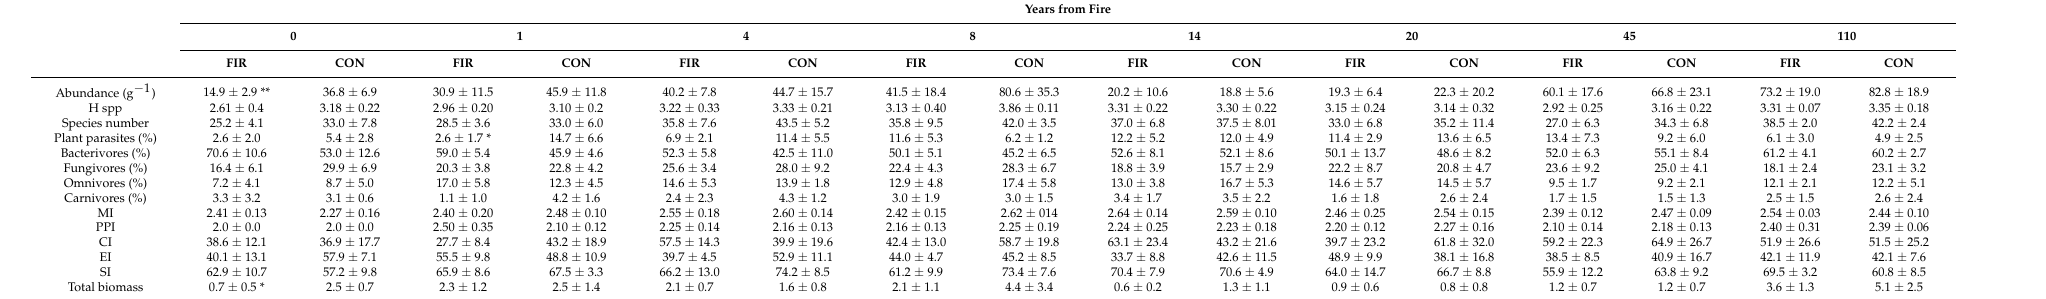
Table 4. Mean value ( ± S.D, n = 6) of nematode community indices taken from forest plots affected by low severe